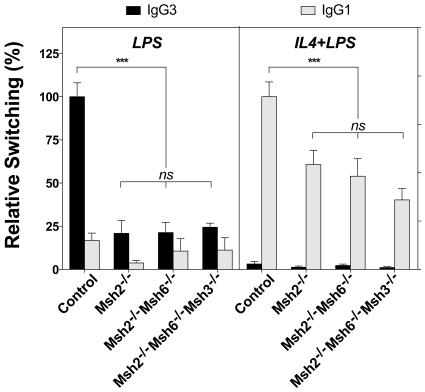
Class switch recombination analysis.
Msh2−/− (N = 2), Msh2−/−Msh6−/− (N = 4) and Msh2−/−Msh6−/−Msh3−/− (N = 3) mice were assayed in five independent experiments and showed a similar decrease in the relative switching to IgG3 and to IgG1 compared to their control littermates (N = 11). The average switching of the wildtype mice in each experiment was defined as 100% and the data shown represent the mean ± SD. P values were calculated using two-tailed unpaired Student's T tests. ***p<0.001 was considered statistically significant; ns, no significant, p>0.05.